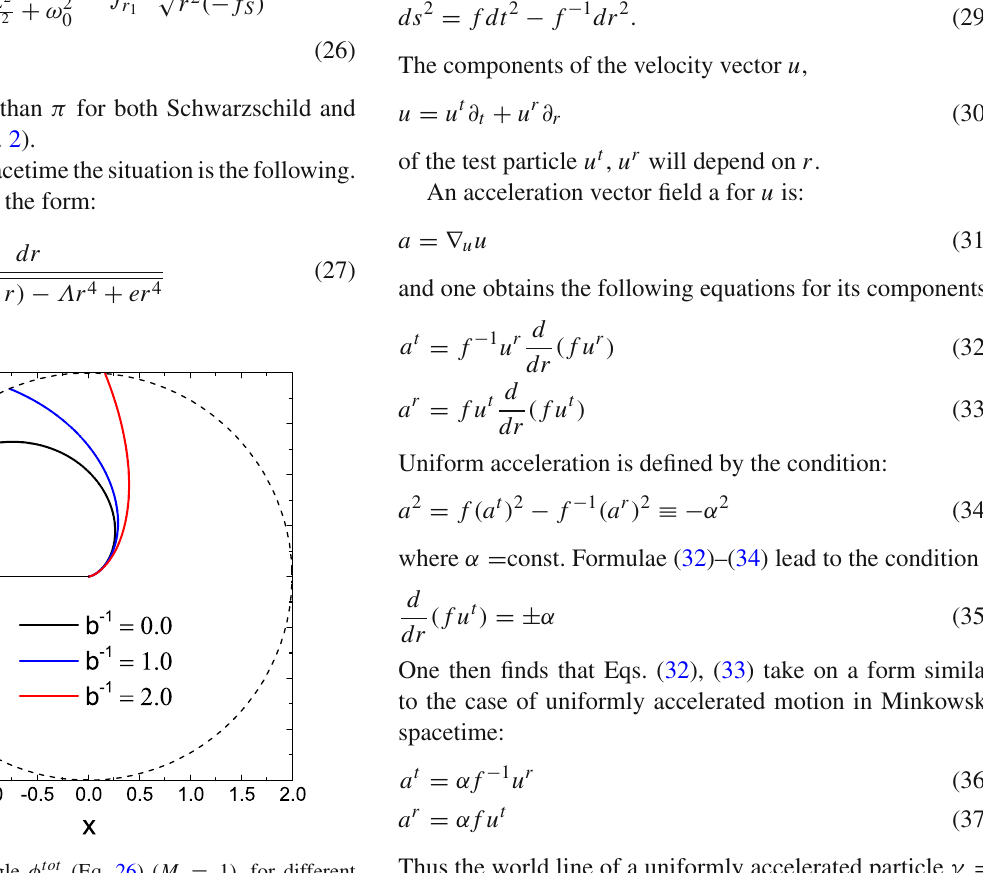
(Eq. 26) ( M = 1), for different S